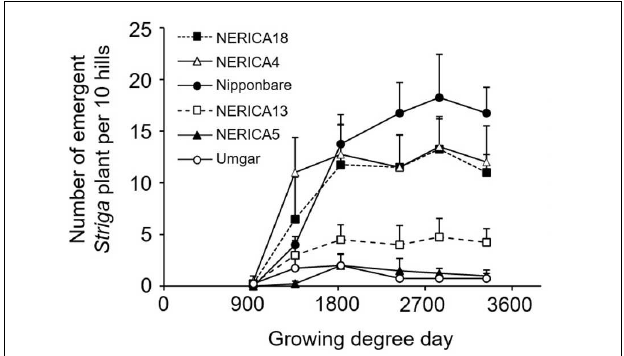
FIGURE 7 | Number of emergent S. hermonthica plants per 10 rice hills in an artificially infested field. Umgar, NERICA5, NERICA13, Nipponbare, NERICA4, and NERICA18 were used in a semi-controlled open air experiment. Bars indicate standard errors of each mean value of four replications.